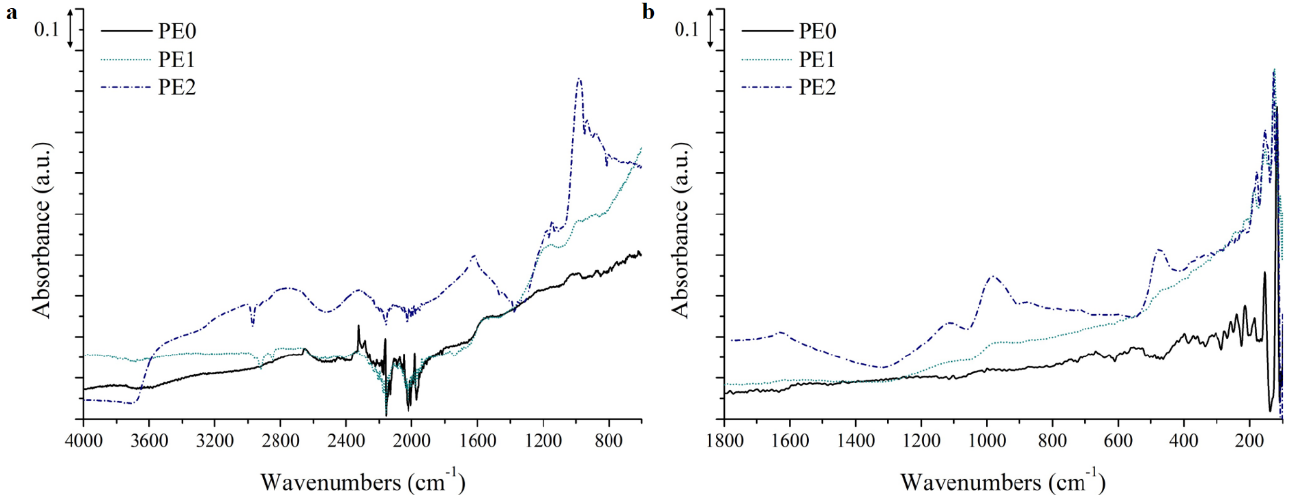
Figure 14. ( a ) Middle and ( b ) far ATR-FTIR spectra of the TGA-FTIR residues.